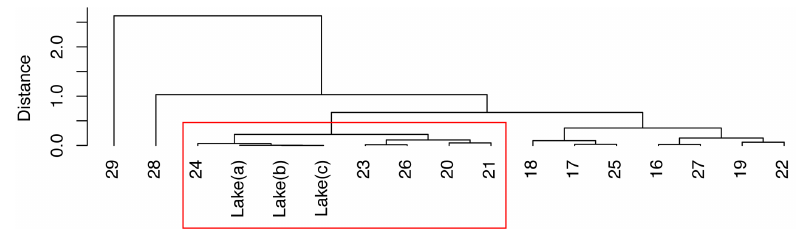
Figure 5. Euclidean hierarchical clustering of fluorescent component C4 from recharging groundwater sites. The fluorescence found at sites 20, 21, 23, 24 and 26 clusters together with lake fluorescence (marked red). This indicates that these sites have a high degree of groundwater recharge. Groundwater well site 24 seems to be especially important in this regard.